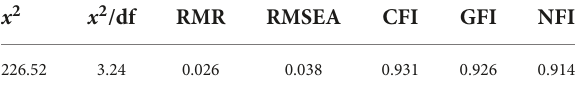
TABLE 5 Goodness-of-fit test of the scale.